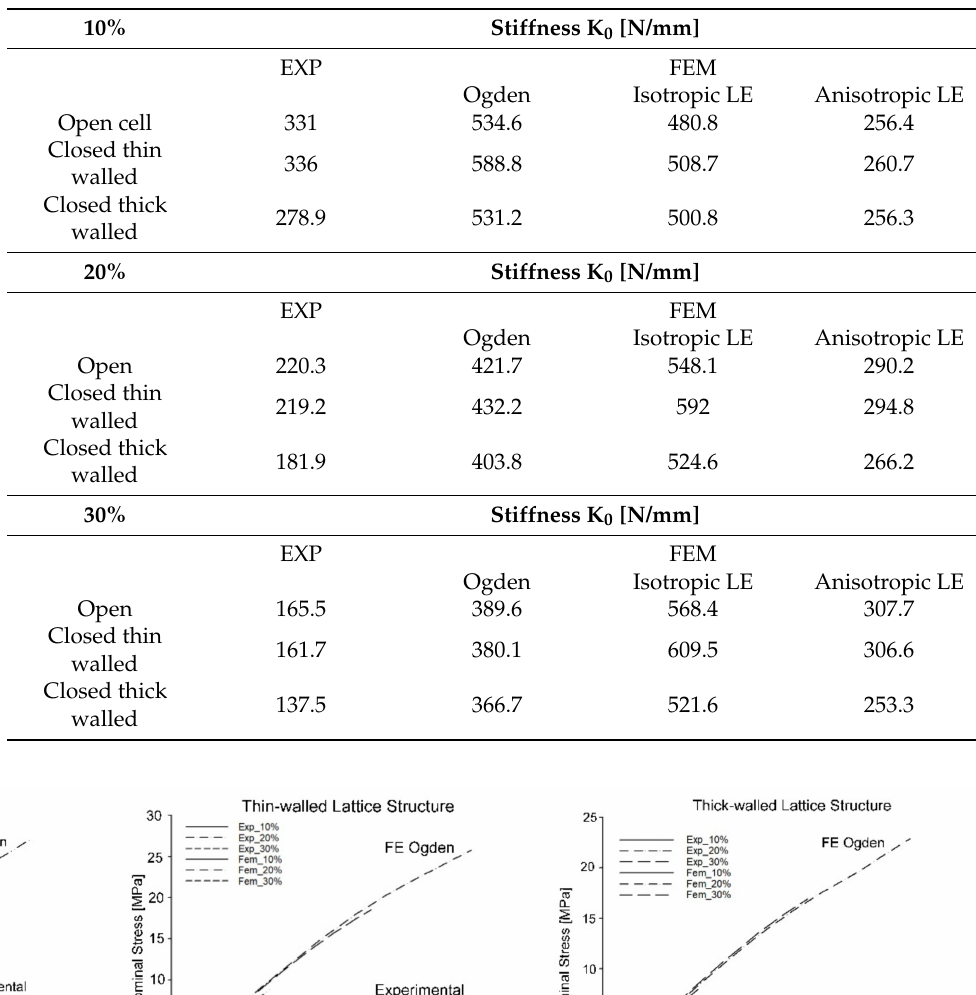
Table 6. Specific stiffness of lattice structures.